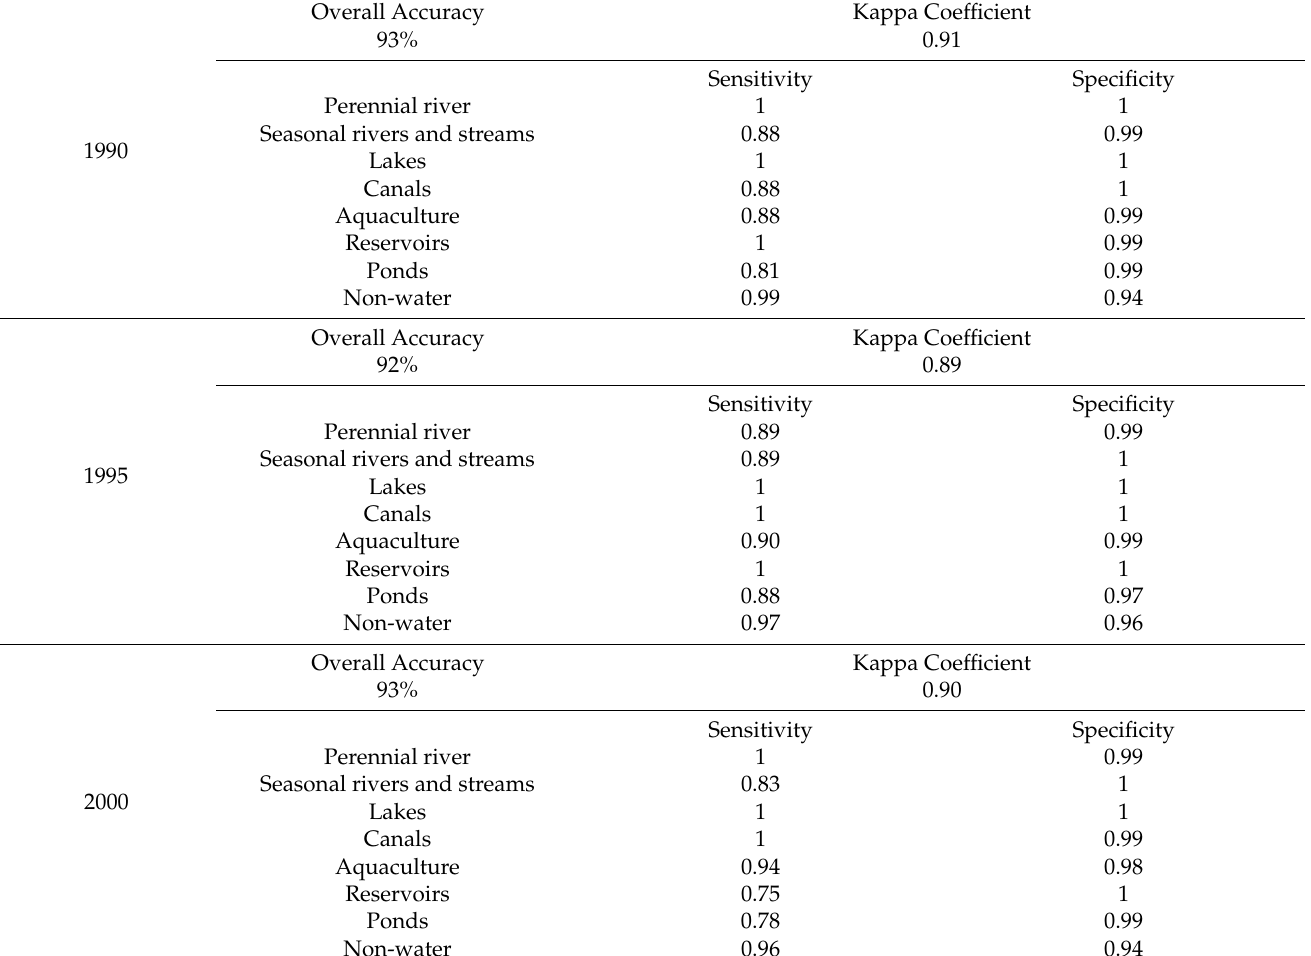
Table A1. Sensitivity and specificity for the classification of each waterbody type in each year of the